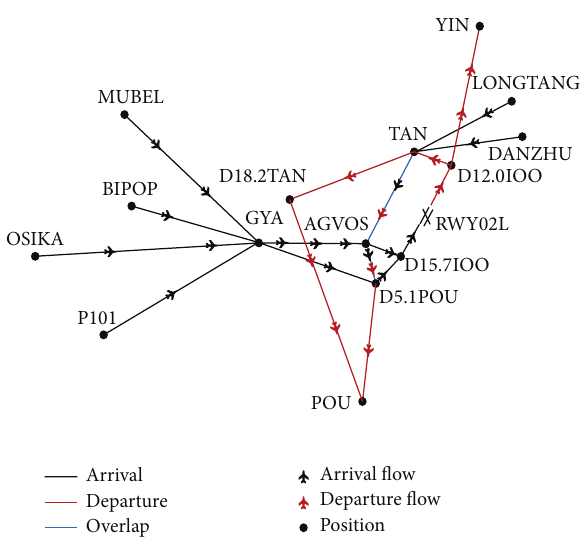
Figure 4: STAR/SID routes to RWY02L ZGGG.